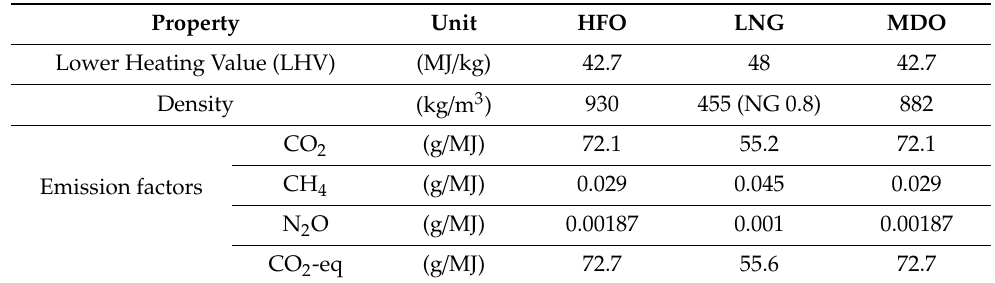
Table 2. Fuel properties based on ecoinvent v2 as implemented in SimaPro software